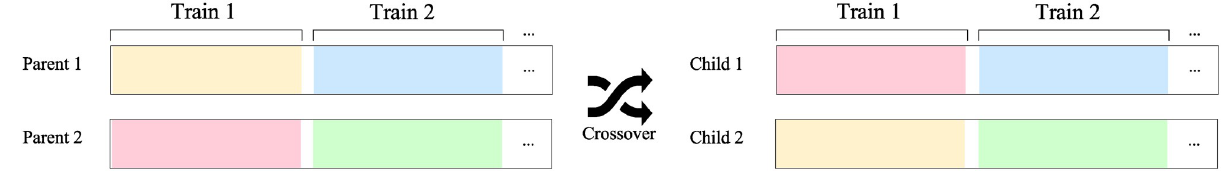
Fig 12. An illustration of